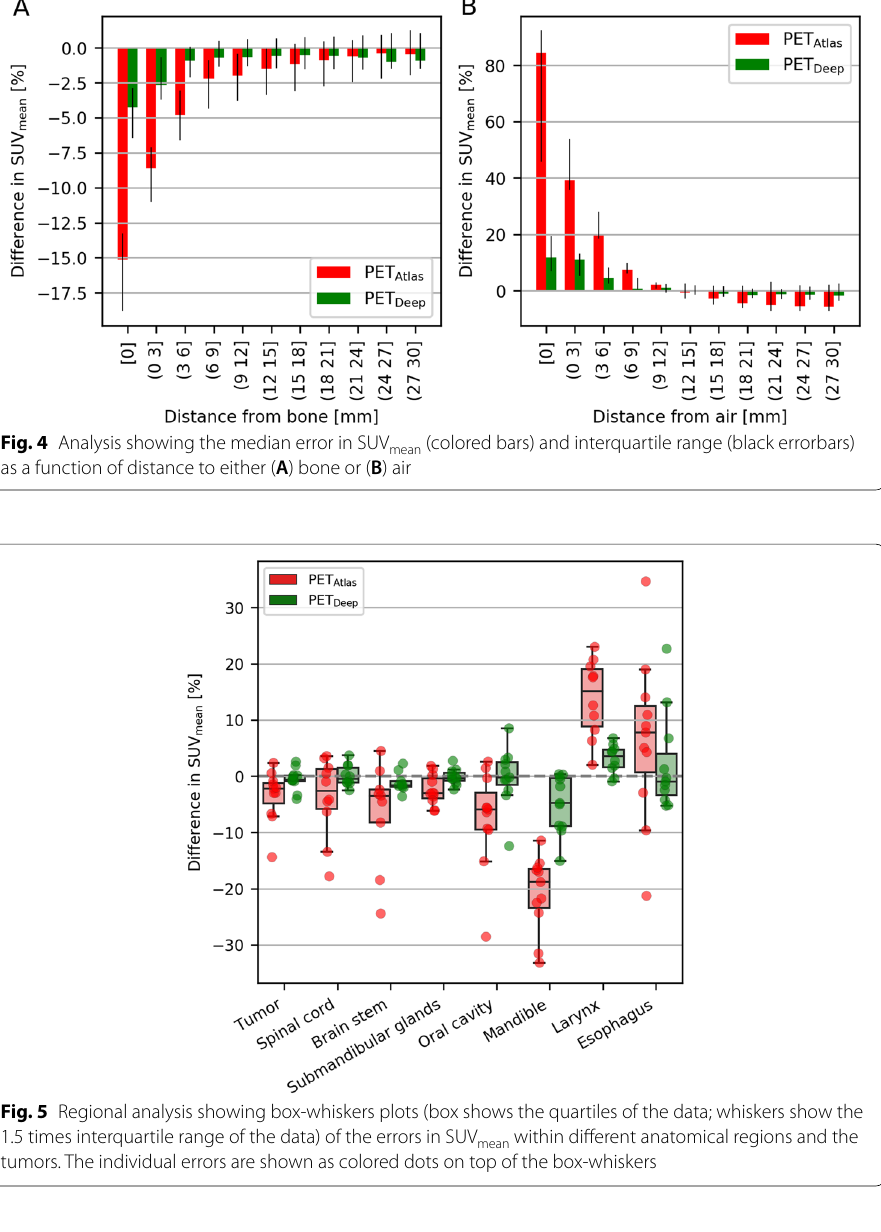
PET Deep (12%) than PET Atlas (84%), and the effect decreases with distance similarly to